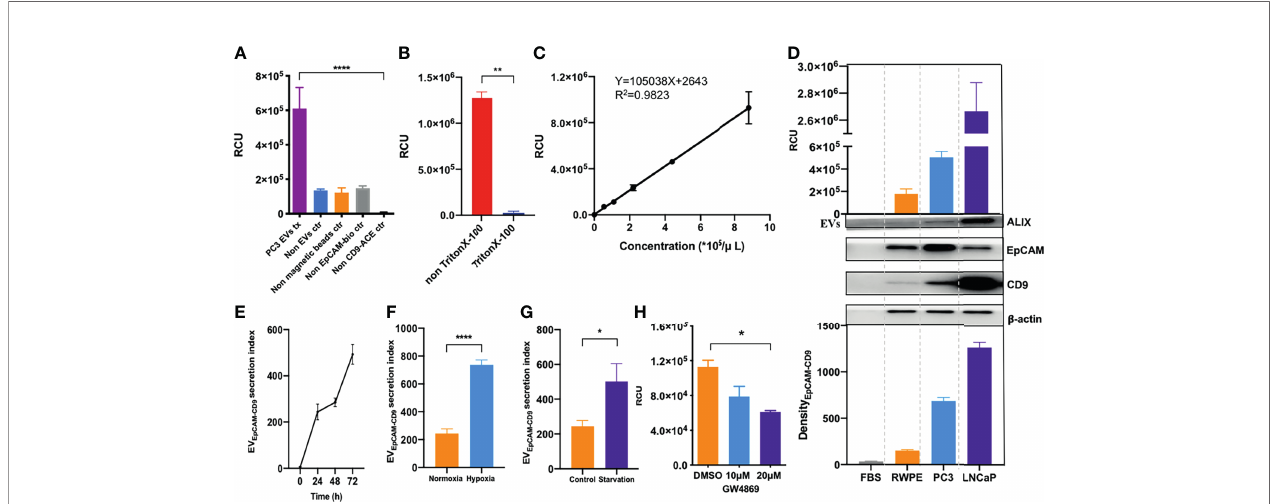
FIGURE 2 | EV EpCAM-CD9 is ultrasensitively detected by chemiluminescent immunoassay and oversecreted under simulated tumor microenvironment. (A) Groups of PC3 EVs, non-EVs, non-streptavidin-labeled magnetic beads, non-biotin-labeled anti-EpCAM antibodies, and non-ACE-labeled anti-CD9 antibodies were detected by our assay. (B) EVs were penetrated by Triton X-100. (C) A standard curve was for EVs from cell line supernatant quanti fi cation using our EV assay. (D) EVs derived from FBS, BPH cell line RWPE-1, and human prostate cancer cell lines PC3 and LNCaP were detected by our EV assay and WB. (E) The changes of EV EpCAM-CD9 secretion index during the growth of PC3 cells. (F) The changes of EV EpCAM-CD9 secretion index when the PC3 cells were cultured under hypoxia. (G) The changes of EV EpCAM-CD9 secretion index when the PC3 cells were cultured under serum starvation. (H) The changes of EV EpCAM-CD9 secreted by PC3 cells with the treatment of 10 and 20 m M GW4869. RCU, relative chemiluminescent unit; EVs, extracellular vesicles; FBS, fetal bovine serum; EVEpCAM-CD9, EpCAM- CD9-positive extracellular vesicles. *P < 0.05,**P < 0.01,****P <